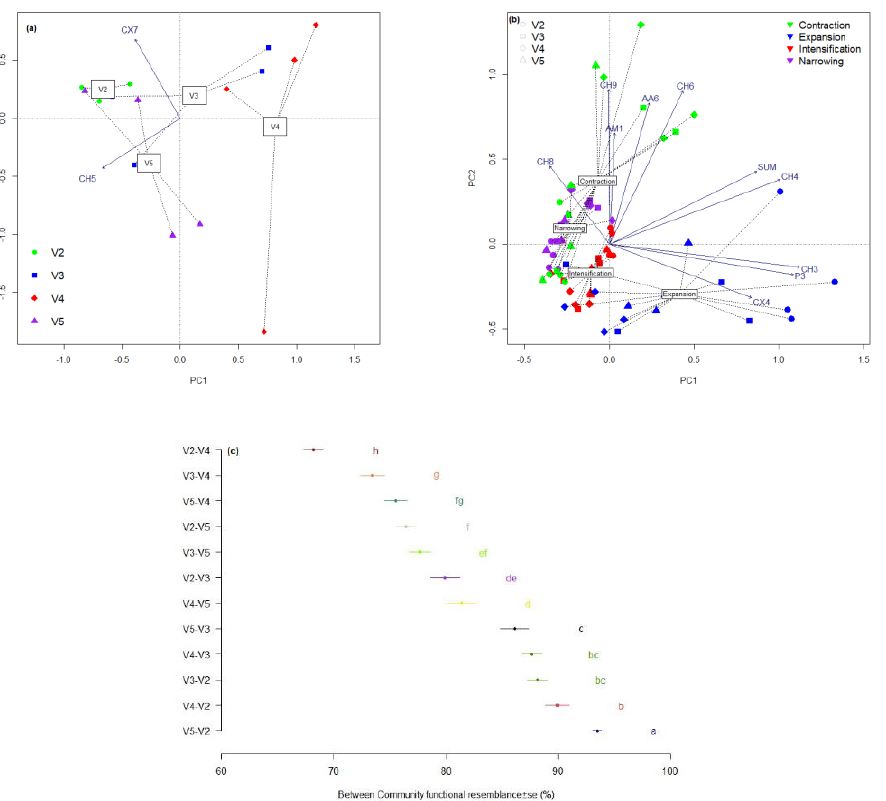
Figure 3. PCA profile of ( a ) sharing in the microbial community (variance explained by axis: Axis 1 − 26.49%, Axis 2 − 22.14%) and ( b ) complementary segments of ecological niche associated with mi- crobial community physiological profile (variance explained by axis: Axis 1 − 24.79%, Axis 2 − 13.31%) and ( c ) LSD comparison of community overlaps due to the application of treatments (different letters near to average ± s.e. present significant differences at p < 0.05). V1 − Control; V2 − 10 t ha − 1 manure; V3 − 10 t ha −1 manure + N50, P 2 O 5 25 kg ha −1 , K 2 O 25 kg ha −1 ; V4 − N100, P 2 O 5 50 kg ha −1 K 2 O 50